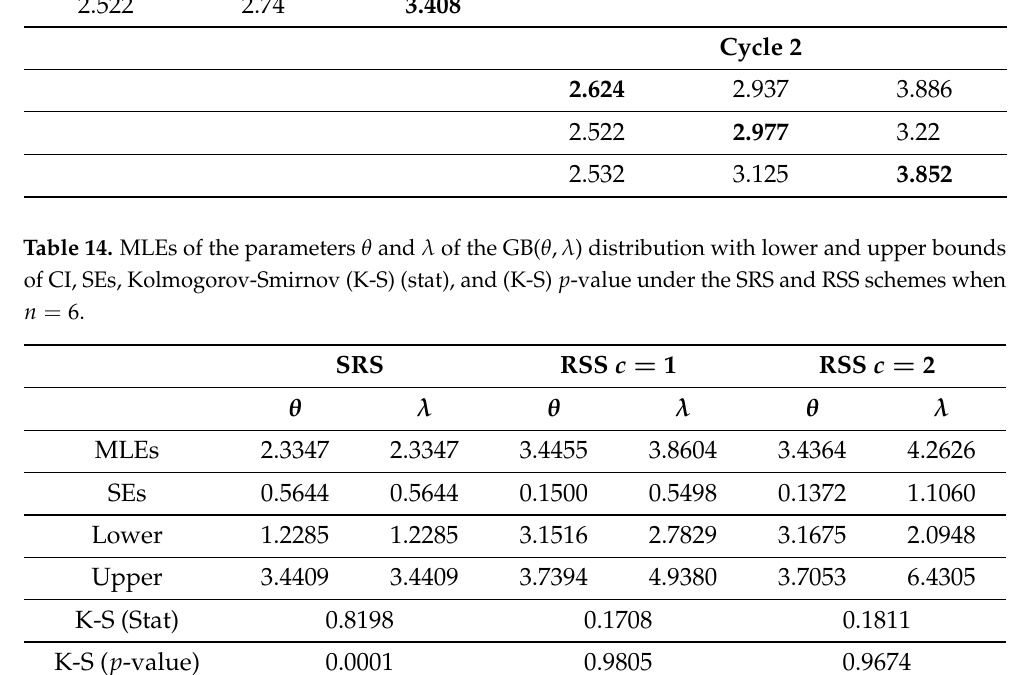
Table 15. RSS scheme from the GB( θ , λ ) distribution when c = 1 and n = 7.